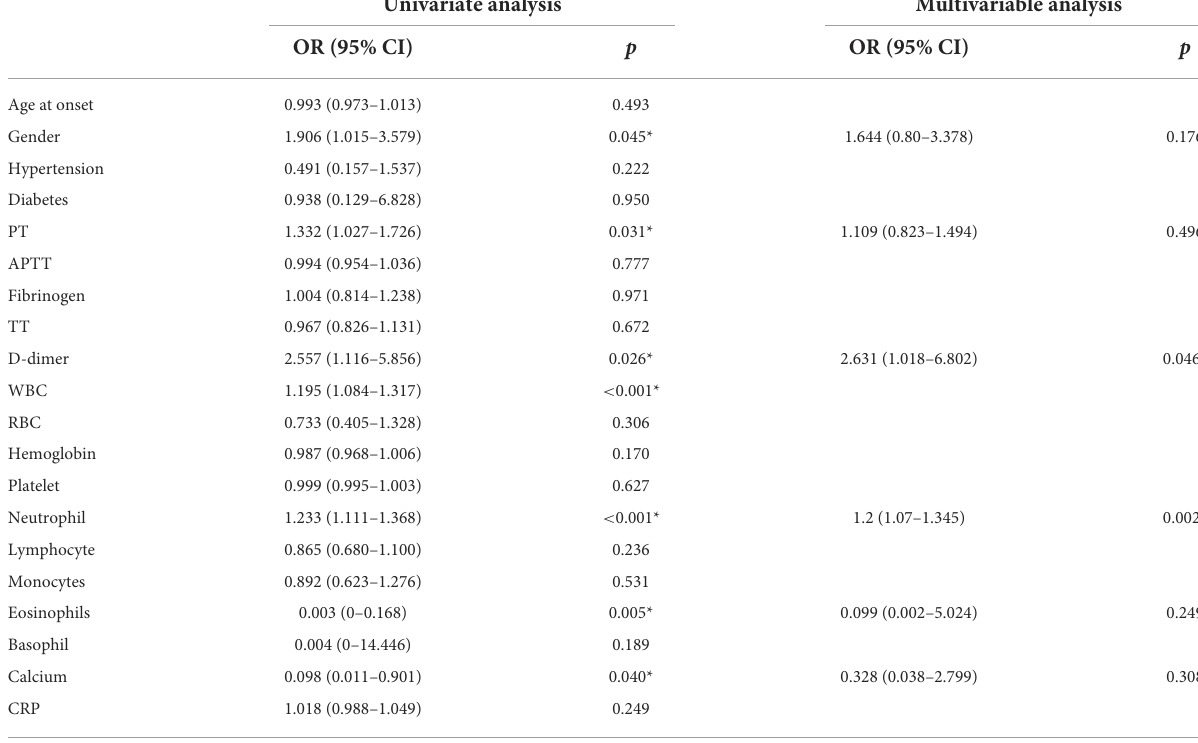
TABLE 4 Univariate and multivariable logistic regression models of disease severity. Univariate analysis Multivariable